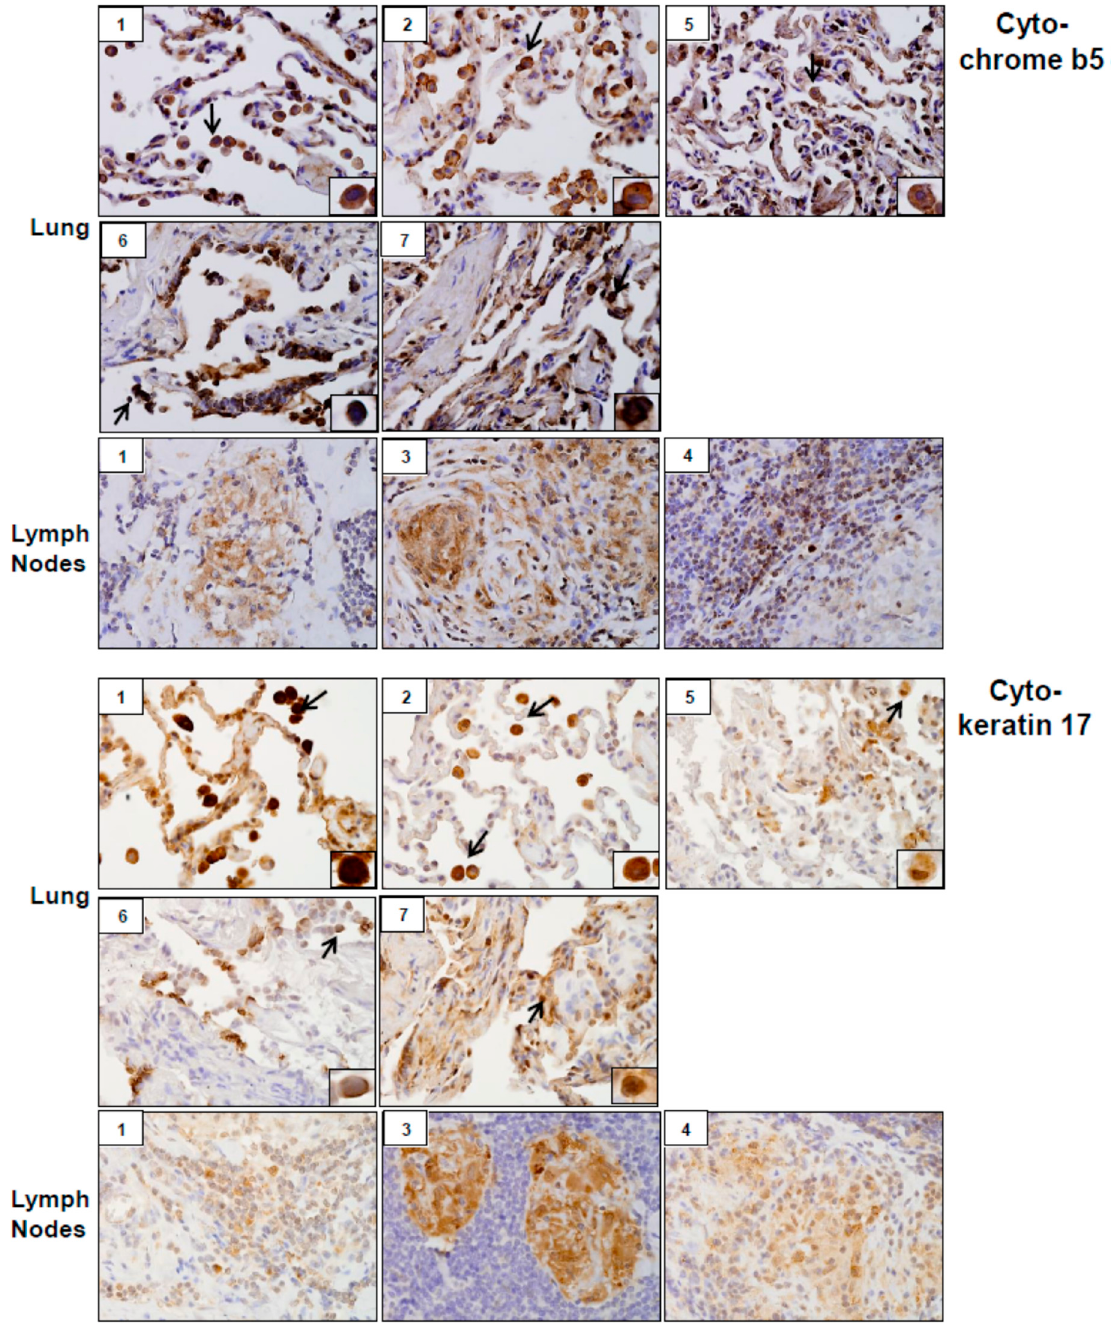
Figure 3. Cytochrome b5 and cytokeratin 17 expression in lung and/or lymph nodes collected from WTC rescue and recovery workers. Sections were immunostained with antibody to cytochrome b5 or cytokeratin 17. Binding was visualized using a 3,3’ diaminobenzidine (DAB) peroxidase substrate kit. One representative section from each patient is shown. Inset, patient number. Magnification, 60×; arrows, alveolar macrophages.